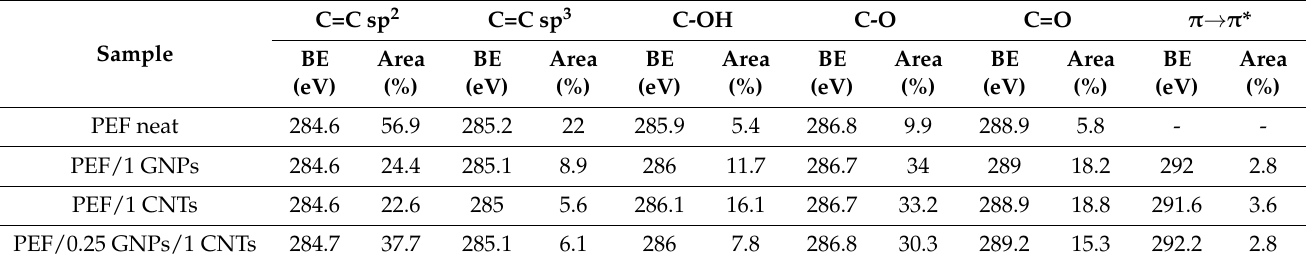
Table 5. Binding energies and % area of the carbon bonds at the C1s spectra of neat PEF, PEF/1 GNPs, PEF/1 CNTs, and PEF/0.25 GNPs/1